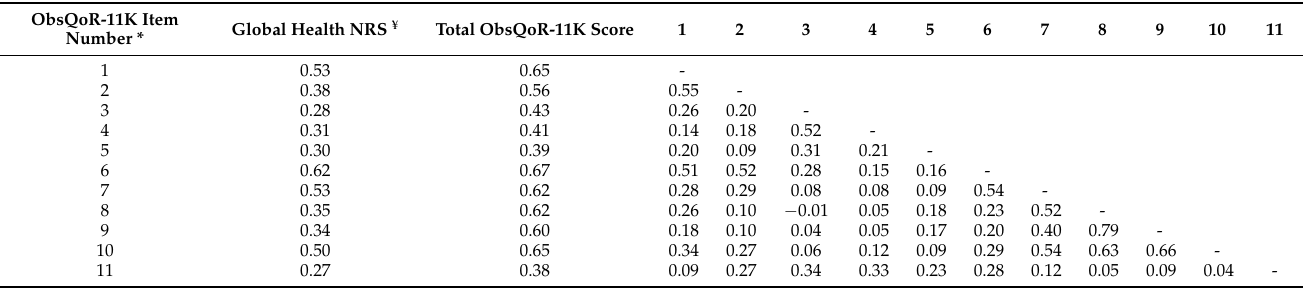
Table 4. Inter-item correlation matrix for